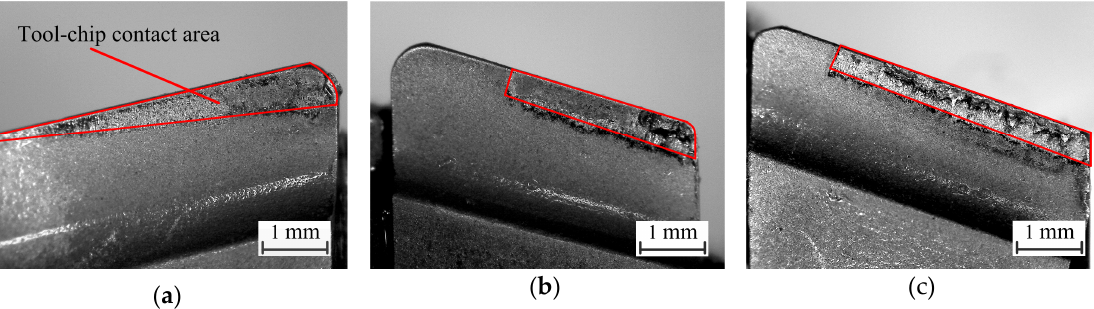
Figure 11. Tool–chip contact area of each tooth for staggered teeth BTA drill: ( a ) the central tooth, ( b ) the intermediate tooth, ( c ) the external tooth. ( b ) the intermediate tooth, ( c ) the external tooth.